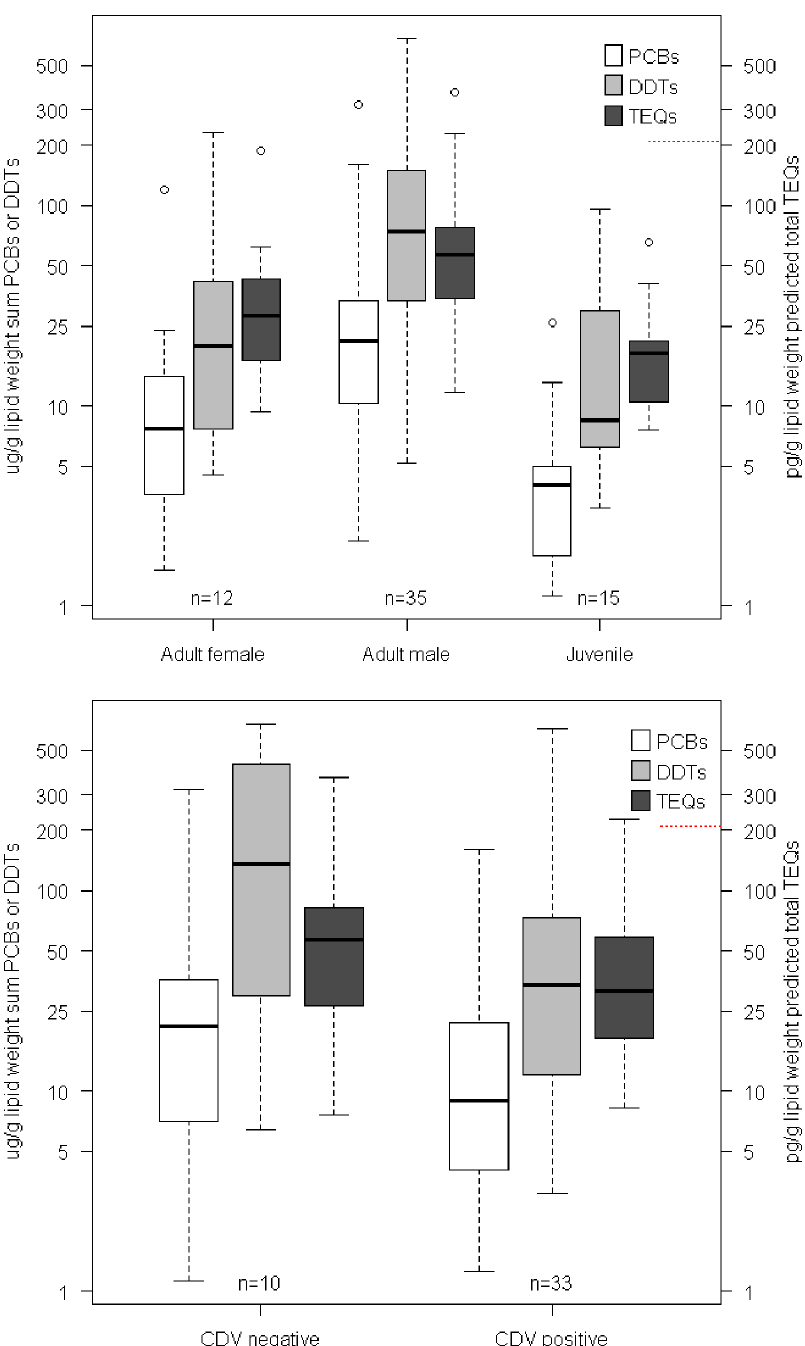
Figure 6. Boxplots of contaminant burdens by sex-age class (top) and CDV status (bottom). Red dashed line indicates proposed threshold for potential toxic effects for g TEQ levels (196 2 220 pg/g lipid weight) derived from experimental studies in harbour seals (De Swart et al. 1994, 1995a, 1995b, 1996, Ross et al. 1995). y axis is plotted on log10 scale.